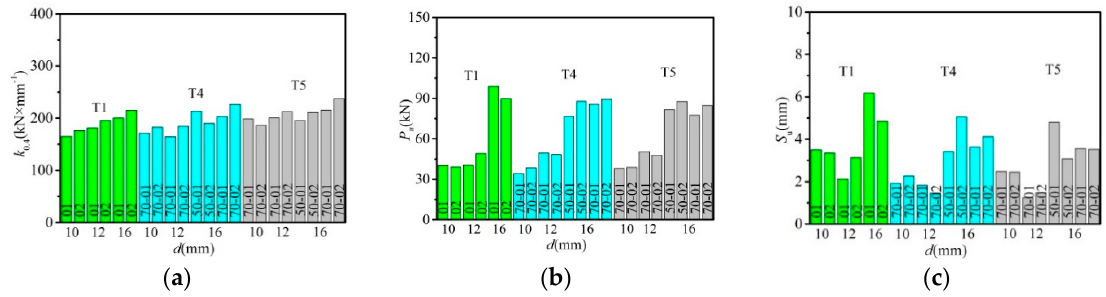
Figure 6. Effect of bolt diameter: ( a ) shear stiffness; ( b ) shear capacity; ( c ) the maximum slip.